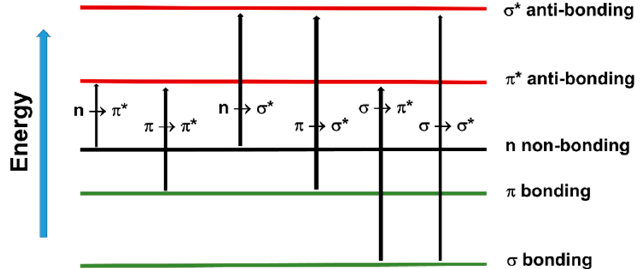
Figure 6. Electron transitions that may occur in organic molecules.